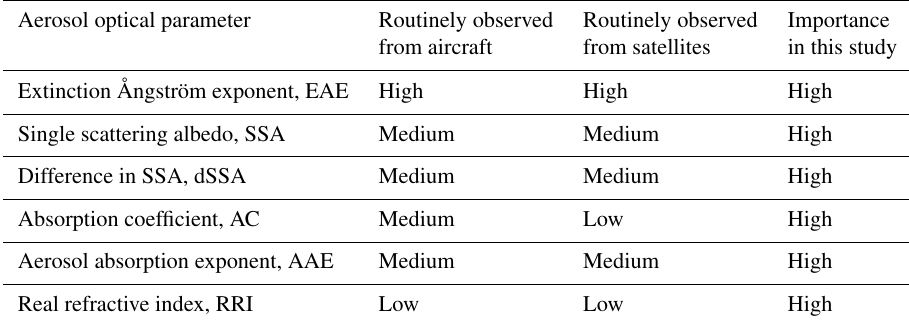
Table 4. Frequency at which the six aerosol optical parameters in our study are routinely derived from aircraft and current passive satellite sensors and importance of these optical parameters in our study. RRI: real refractive index; AAE: absorption Ångström exponent; AC: absorption coefficient; dSSA: difference in single scattering albedo; SSA: single scattering albedo; EAE: extinction Ångström exponent. Aerosol optical parameter Routinely observed Routinely observed Importance from aircraft from satellites in this study Extinction Ångström exponent, EAE High High